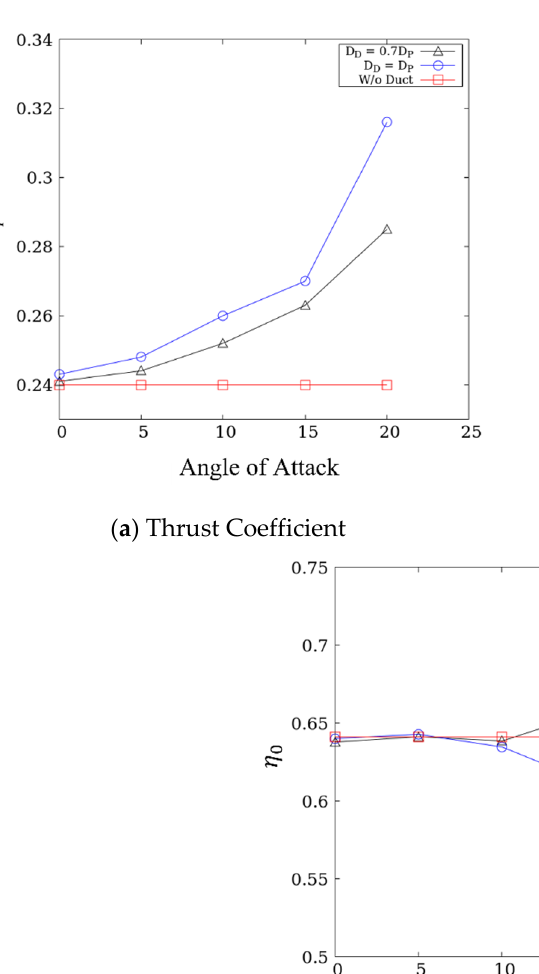
( d ) AoA = 20° Figure 13. Cavitation of cases with 𝐷 (cid:3005) = 𝐷 (cid:3017) . Figure 14 represents the thrust and torque coefficients for different angles of attack. Regardless of the size of the duct, as angle of attack increased, there was an increase in both the coefficients of thrust and torque compared to the propeller without the duct. The large duct caused higher thrust and torque than the small duct in all angles of attack under the cavitating condition. The large cavitation area in the small duct reduced the thrust and torque compared to the large duct. The propeller equipped with ducts provided a higher thrust and torque compared to the propeller without a duct. Regardless of the size, all ducts showed increased thrust and torque with higher angles of attack. From the propeller efficiency in Figure 14c, for small angle of attack of both size of the ducts, there was neg-